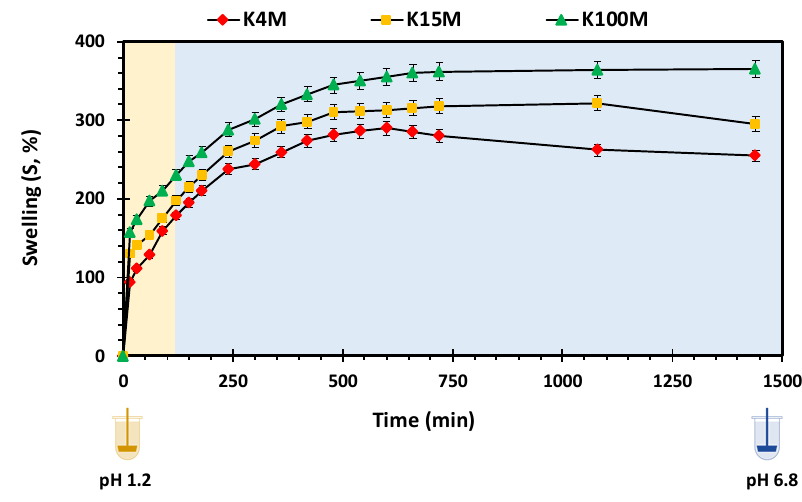
Figure 7. Swelling vs. time profile of 3D printed HPMC matrix tablets. Table 6. Swelling and erosion kinetics parameters of HPMC/glipizide hydrophilic matrices (n = 5). Type of matrix tablet